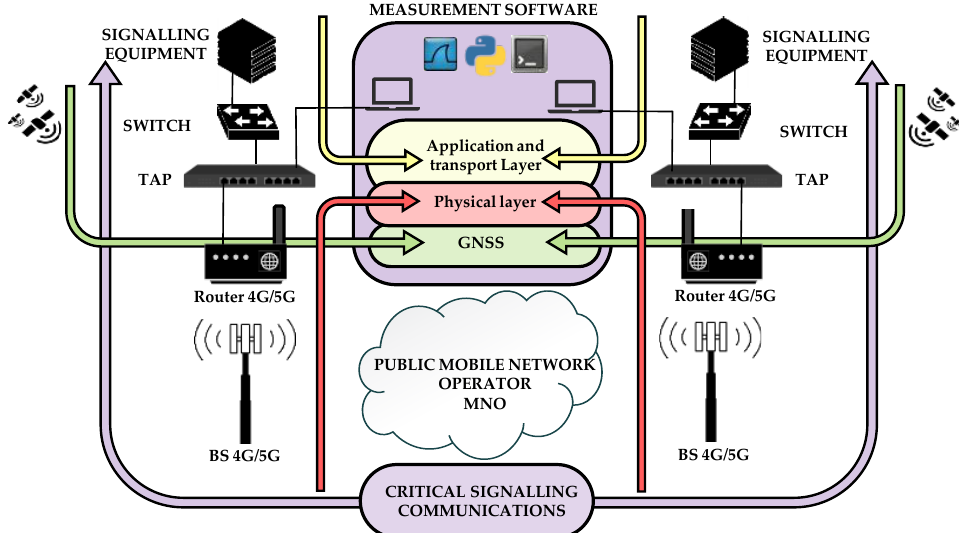
Figure 2. Prototype and measurement set-up